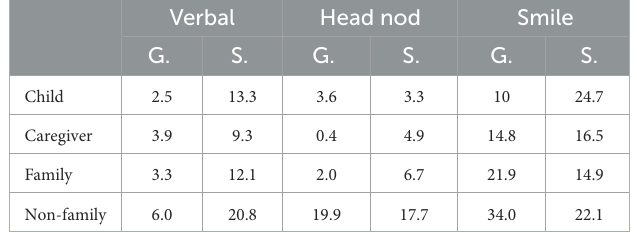
TABLE 3 Average number of generic vs. specific BC produced per participant in each modality. Note that here the numbers for “Caregiver” only concern their interaction with children. Family and non-Family groups include only participants from the caregiver-adult condition.